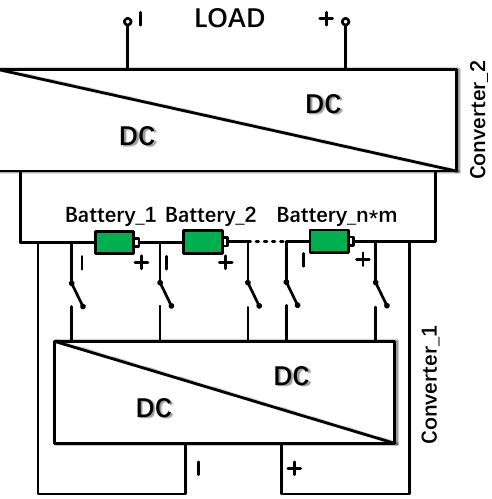
Figure 9. Conventional converter equalization circuit.